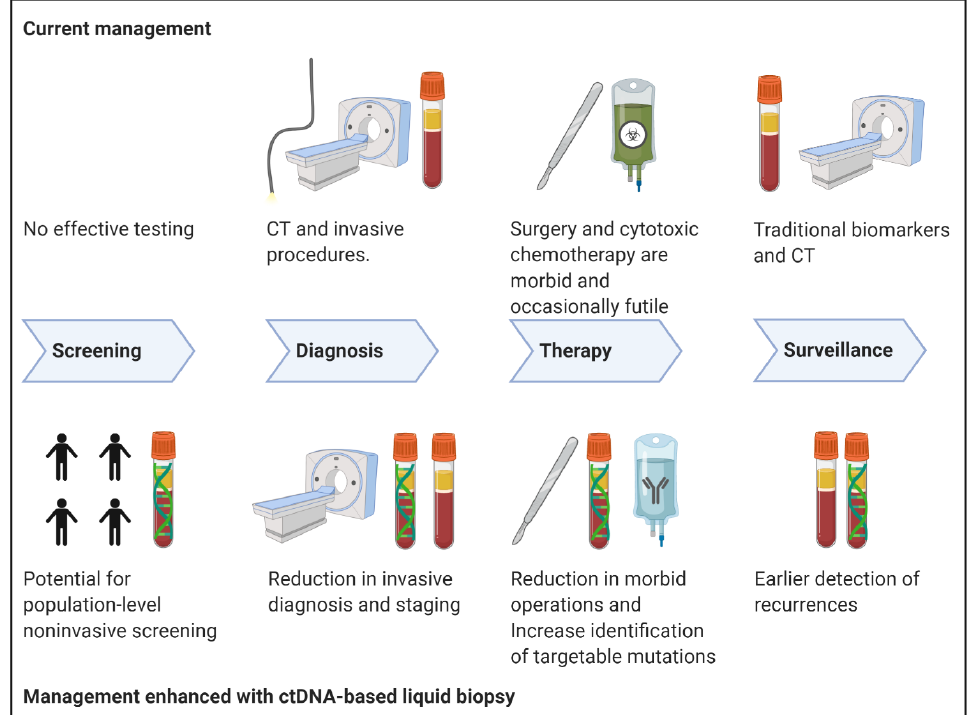
Figure 1. Potential impact of ctDNA-based liquid biopsy on multimodal management of pancreatic ductal adenocarcinoma (PDAC). Created with BioRender (BioRender.com, accessed 10 September 2020). CT, computed tomography.